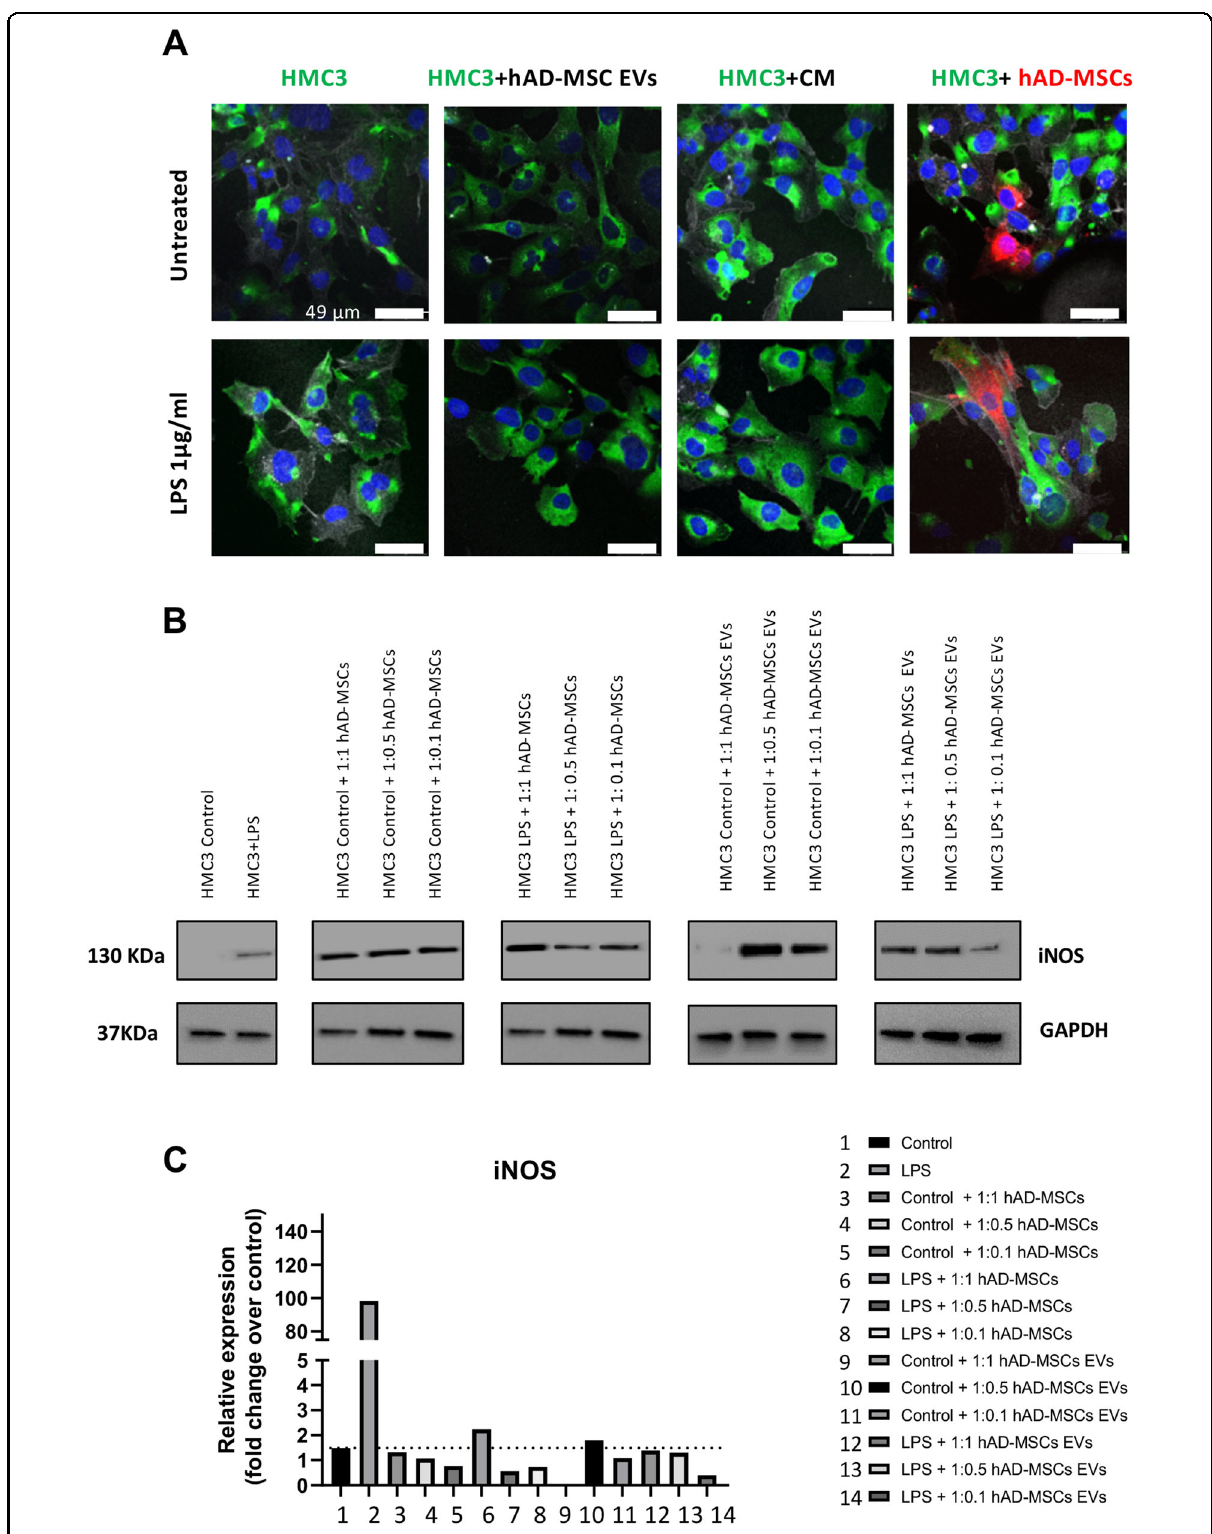
Fig. 4 Effects of hAD-MSCs on microglia immunoin fl ammatory phenotype. A Immuno fl uorescence staining for M1 marker CD11b (green), F- actin phalloidin (white), and DAPI (blue). hAD-MSCs are labeled with CellBrite Orange (red). B Proteins expression levels of inducible nitric oxide (iNOS). C Western blot quanti fi cation. iNOS inducible nitric